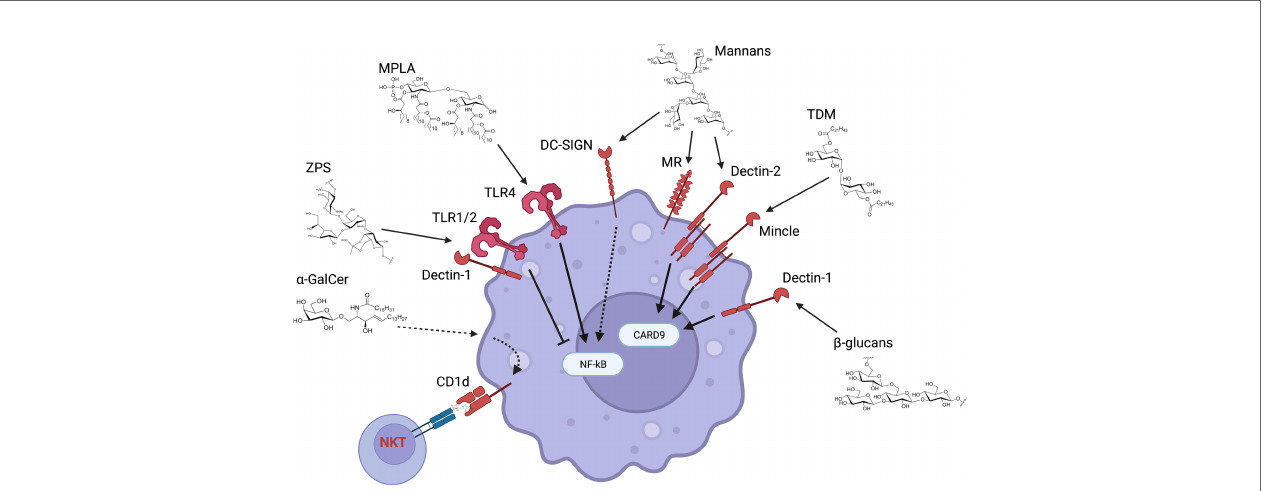
FIGURE 3 | Innate receptors and pathways activated by carbohydrates as vaccine adjuvants. Carbohydrates that have been tested as vaccine adjuvants can activate a multitude of receptors and downstream pathways. b -glucans and mannans respectively bind to Dectin-1 and -2 and lead to CARD9 activation (even though CARD9-independent pathways have also been described). CARD9 plays a key role in NF- k B activation and therefore in the induction of pro-in fl ammatory genes. A similar pathway is activated by Mincle agonists such as trehalose 6,6 ’ -dimycolate (TDM). Mannans also bind to mannose receptor (MR) and DC-SIGN. MR has mainly been involved in endocytosis and it is unclear whether it activates downstream pathways, while DC-SIGN enhances NF- k B activation upon concurrent TLR stimulation. Monophosphoryl lipid A (MPLA) activates the TLR4 receptor complex mainly through its lipid chains, with the sugar backbone providing a scaffold for the lipid chains. Zwitterionic polysaccharides such as PSA-1 activate both TLR1/2 and Dectin-1, leading to reduction of NF- k B pro- in fl ammatory activity. Finally, sphingolipids such as a -GalCer are presented to and activate NKT cells through CD1d but can also directly activate innate immune cells in a CD1d-dependent